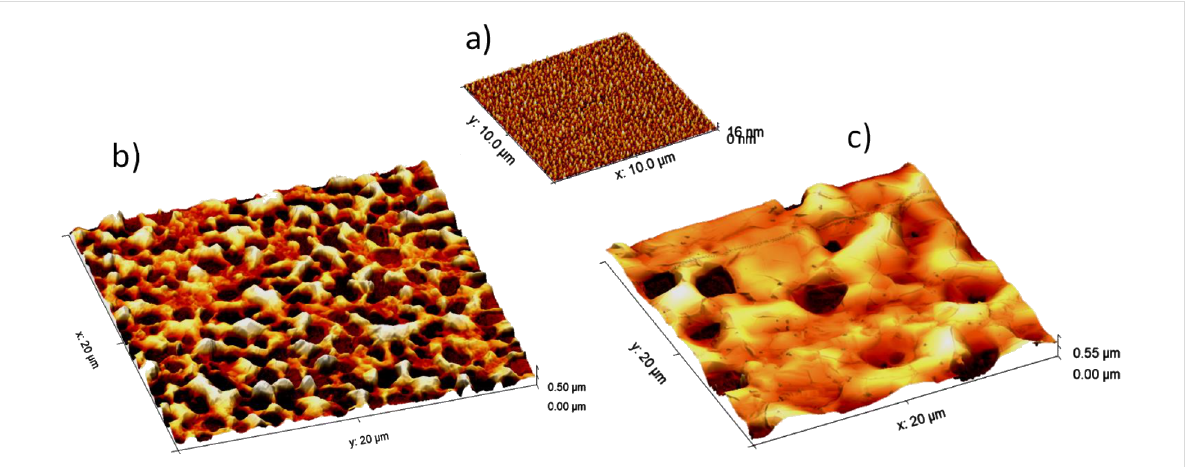
Figure 1: 3D AFM image of the surface of the Ni film: a) as grown, b) after graphene growth with a high heating rate (200 °C/min) and c) after graphene growth with a slow heating rate (50 °C/min). Observe the folded structure of the graphene on the Ni surface in c).